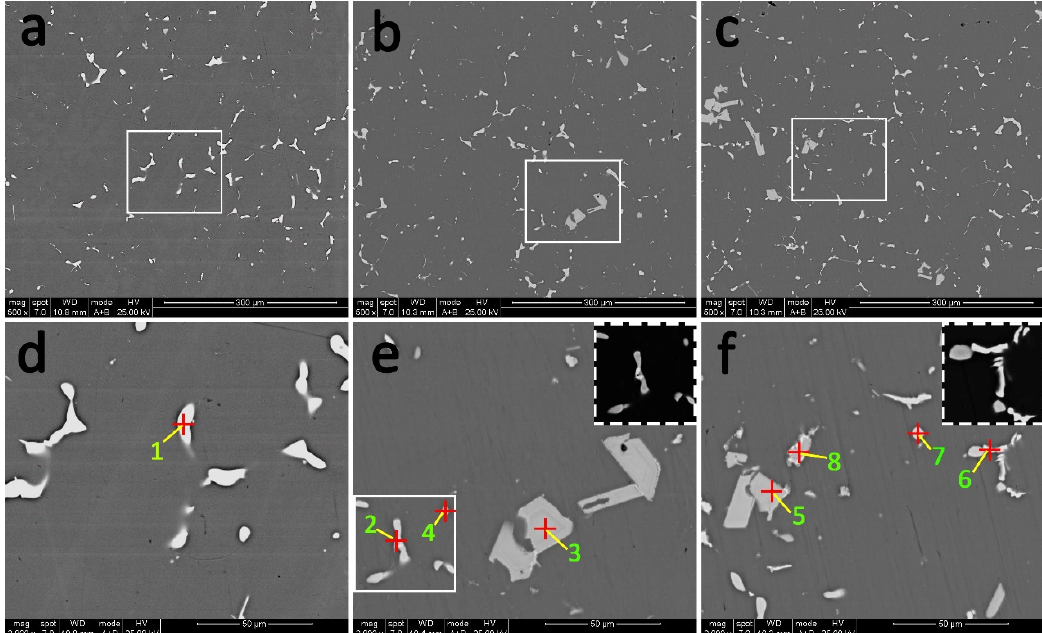
Materials 2021 , 14 , x FOR PEER REVIEW Figure 6. Backscattered electron (BSE) images of alloys after T6 heat treatment. ( a , d ) Er-free; ( b , e ) 0.09Er; ( c , f ) 0.20Er alloys. Table 2. EDS analysis (wt %/at %) of red points marked in Figure 4.